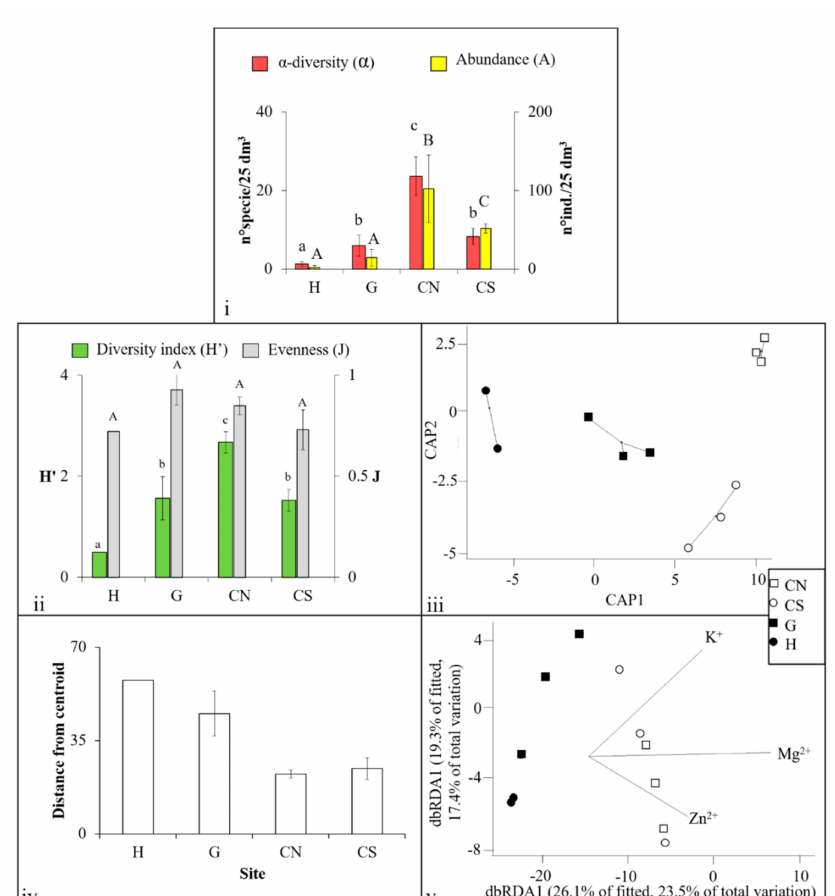
Figure 4. ( i ) α -diversity ( α ) and abundances (A) trends of Polychaeta assemblages, ( ii ) diversity (H’) and evenness (J) indices trends of Polychaeta assemblages. Bars with different letters (a, b, c or A, B, C) are related to sites showing significant di ff erences ( p < 0.05). ( iii ) CAP for the factor Site: straight lines are related to distances of each site replicates from their cluster centroid, formally explained in ( iv ): mean ( ± SE) multivariate dispersion (PERMDISP, small-scale heterogeneities) of the Polychaeta assemblages calculate on their abundances. ( v ) The dbRDA ordination for Polychaeta heterogeneities vs. the significant explanatory environmental variables. Vector overlays represent multiple partial correlations of the explanatory variables with the dbRDA axes. See text for further